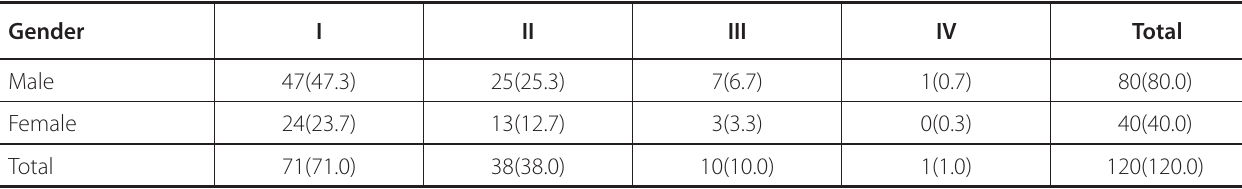
Table 4 . Comparison of types between gender groups.